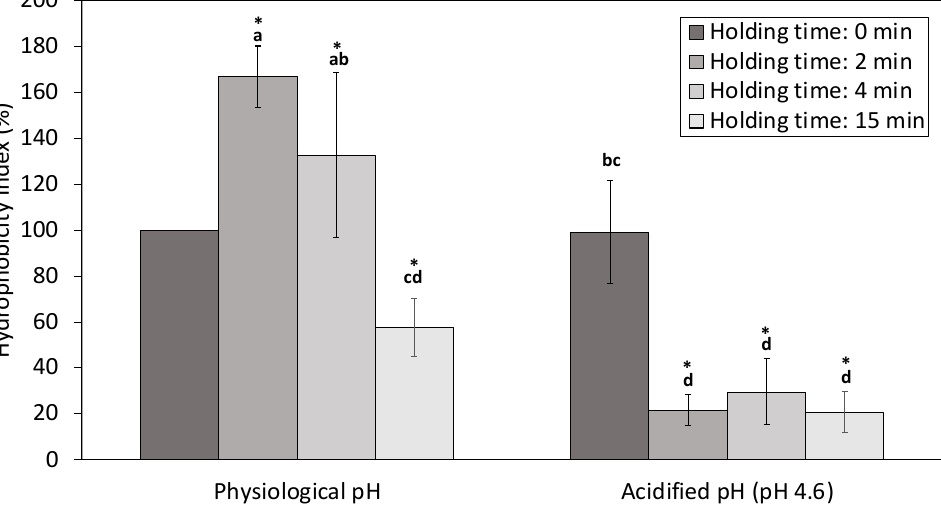
Figure 6. Surface hydrophobicity results. Hydrophobicity Index (%) of high-pressure processing (HPP) treated native whey concentrate supernatant (NWC sup ) (2, 4 and 15 min) regarding the control. Bar errors mean standard deviation. a–c Mean values with different superscripts differ significantly ( p < 0.05) according to Tukey test. * Significant differences with untreated samples.